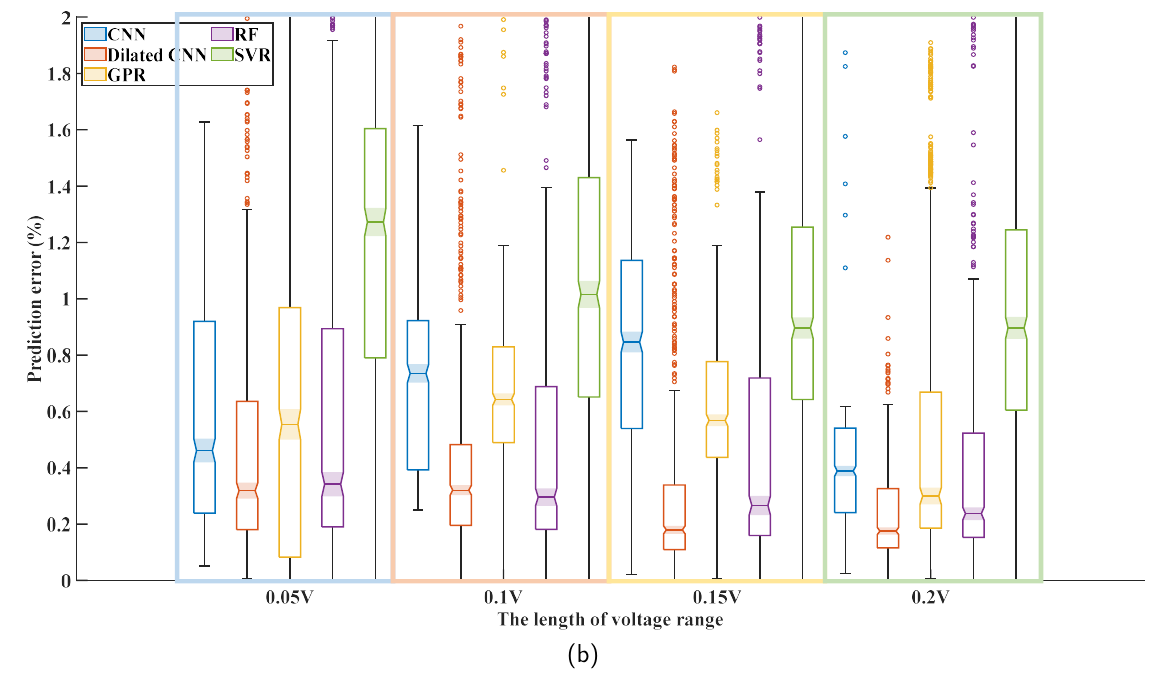
Figure 13. ( a ) Box chart of prediction error for different methods when using input data of voltage range at different lengths with Cell 02 as the test set. ( b ) Box chart of prediction error for different methods when using input data of voltage range at different lengths with Cell 04 as the test